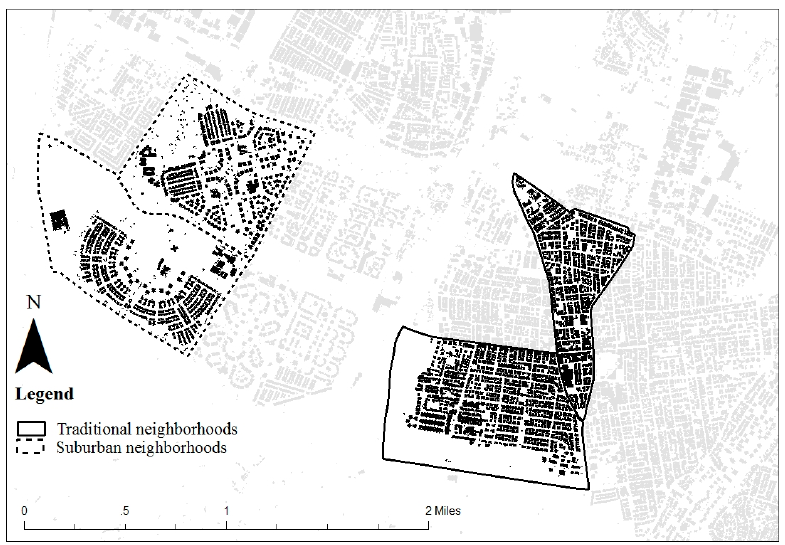
Figure 1. Figure ground of the study area.